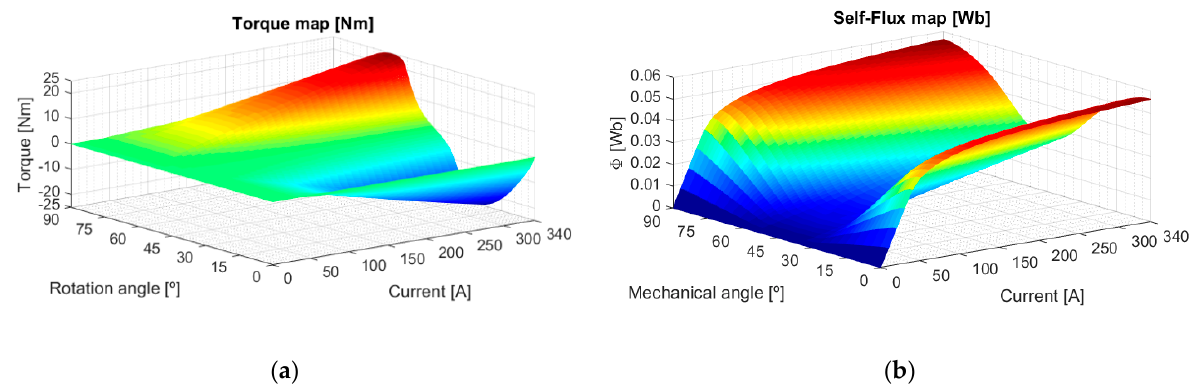
Figure 6. FEM simulation results: ( a ) torque map of a machine phase as a function of current and angle; ( b ) flux map of a machine phase as a function of current and angle.